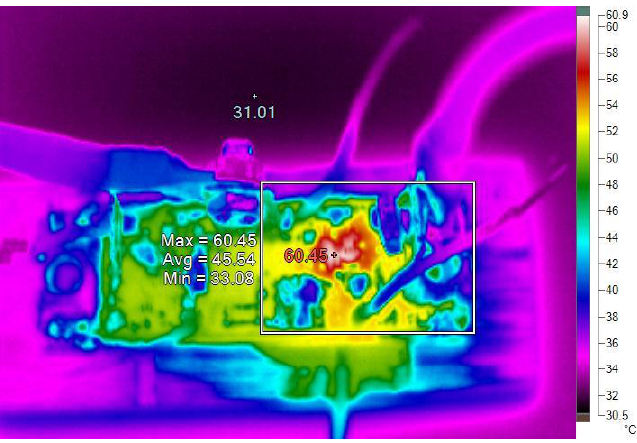
Figure 13. The temperature distribution of IGBT taken by the infrared imager.